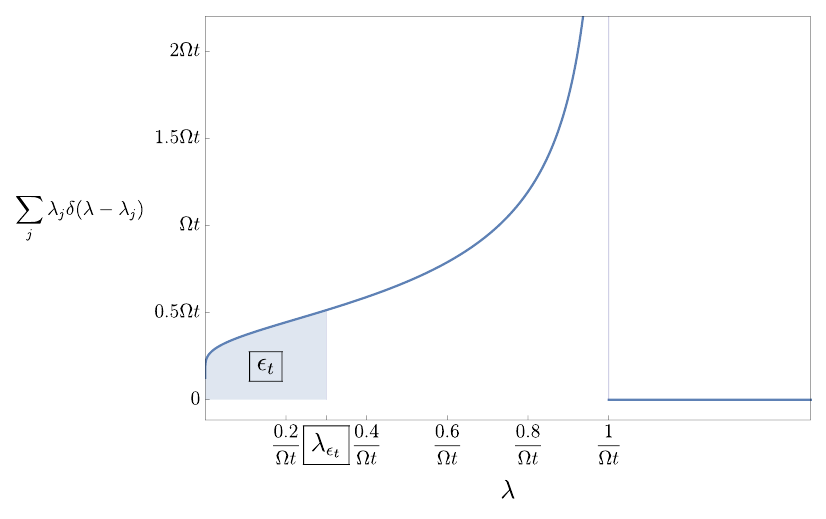
(cid:113) e d 2 L 2 . The shaded area has probability 2 π